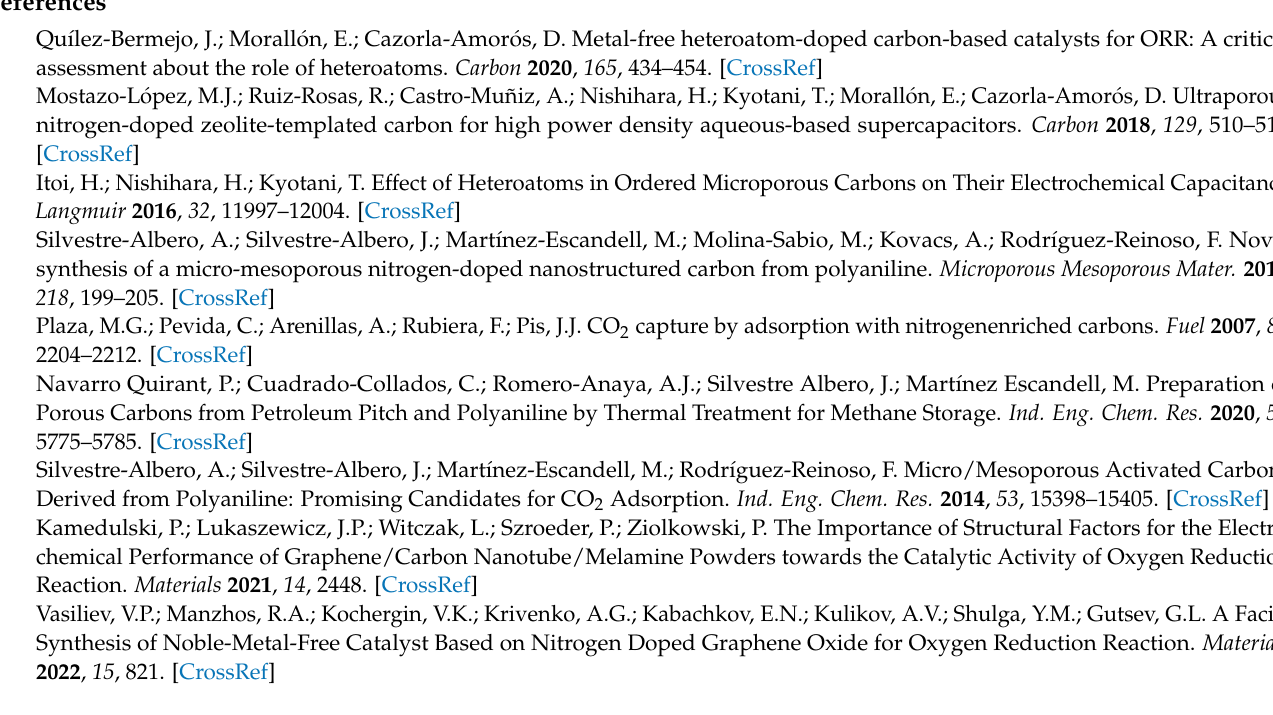
Figure A12. Relationship between microporous volume and adsorption capacity of CO 2 (0 °C, 1 bar).